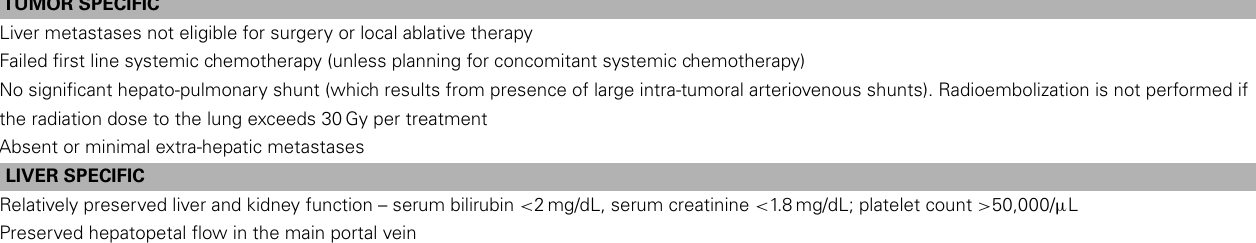
Table 1 | Patient selection criteria forYttrium-90 radioembolization of hepatic metastases from colorectal cancer . TUMOR SPECIFIC